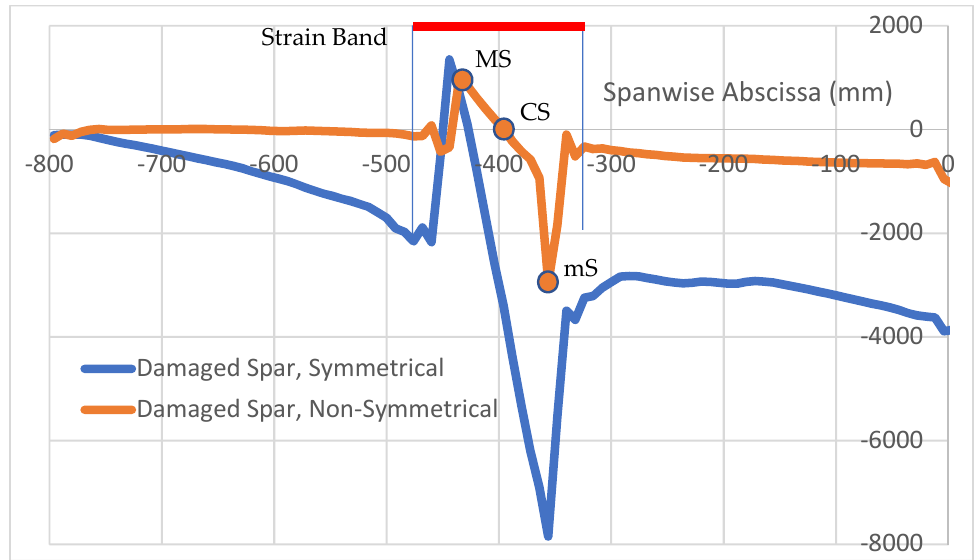
Figure 19. Non-symmetrical vs. symmetrical load effects: longitudinal strain function for damaged and non-damaged spar.